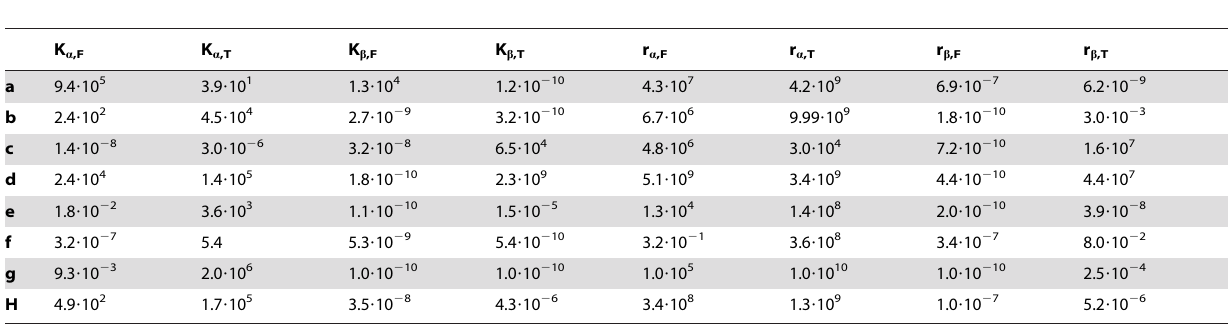
Table 1. Resulting optimized parameters of the eight courses ( a, b, c, d, e, f, g and h ) after running the mono-objective